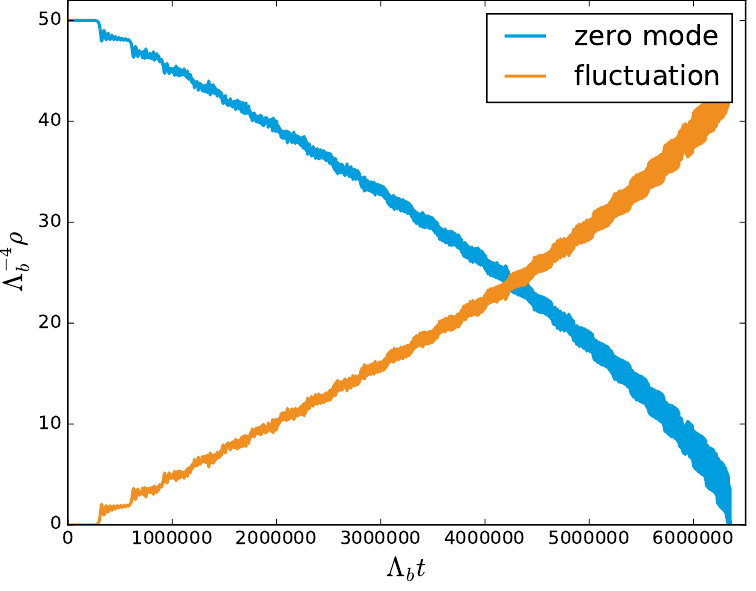
Figure 10 . Time evolution of energy of zero-mode and (cid:13)uctuations. We take f =1000(cid:3) b , _ (cid:30) 0 =10(cid:3) 2 (cid:22) 3 = 0, and H = 0.